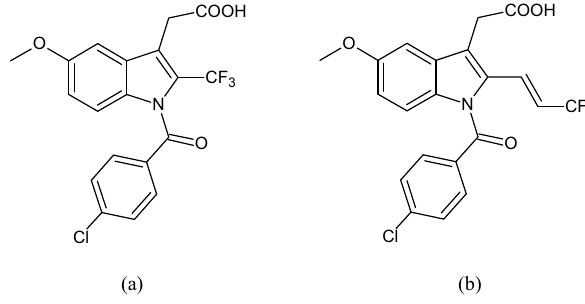
Figure 1: Chemical structure of compounds: ( a ) 6 and ( b ) 7